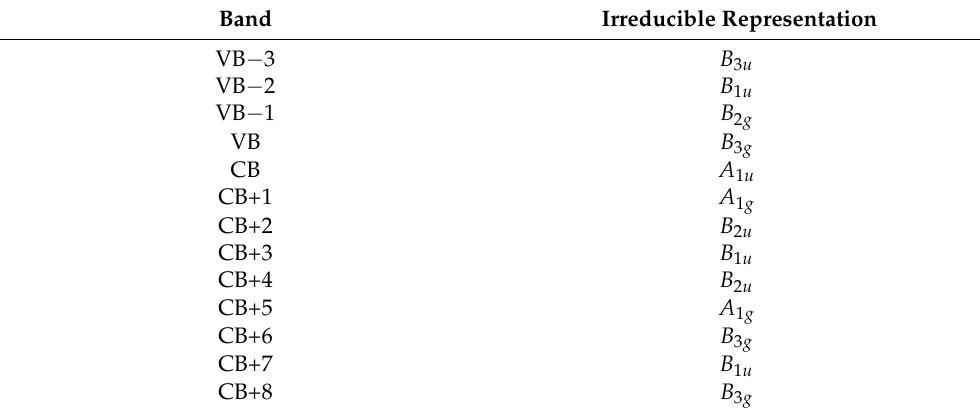
Table A5. Irreducible representations for bands at the M point. All bands are non-degenerate.